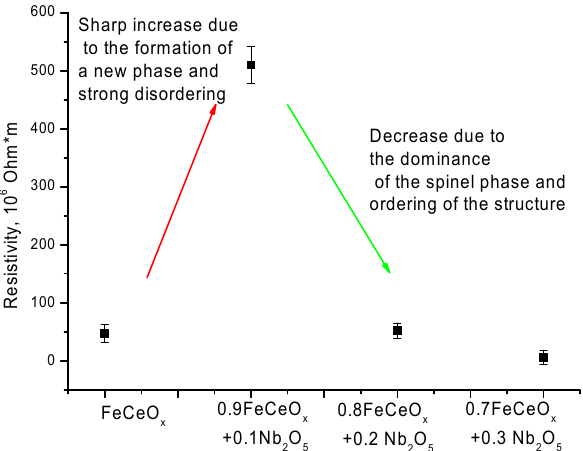
Figure 11. Graph of change of resistance value depending on type of nanoparticles.